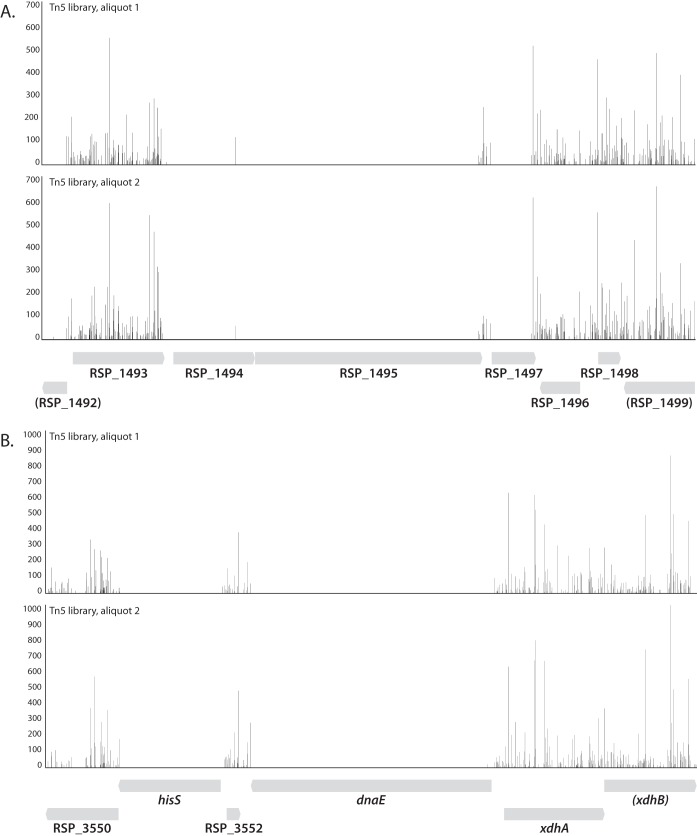
Examples of essential genes as determined by Tn-seq. An R. sphaeroides Tn5 mutant library was generated on rich (LB) plates grown aerobically. Transposon insertions were determined as described in the text. (A) Genomic region surrounding the essential genes RSP_1494 (putative aspartate aminotransferase), RSP_1495 (DNA translocase FtsK), and RSP_1497 (putative outer membrane lipoprotein carrier protein). (B) Genomic region surrounding the essential genes hisS (RSP_3551, histidyl-tRNA synthetase) and dnaE (RSP_3553, DNA polymerase III, α subunit).